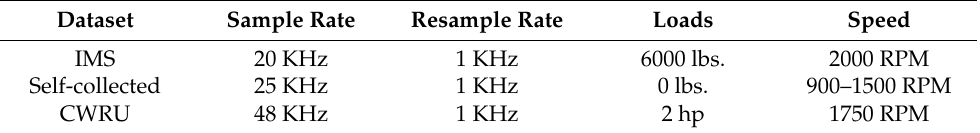
Table 2. Description of the